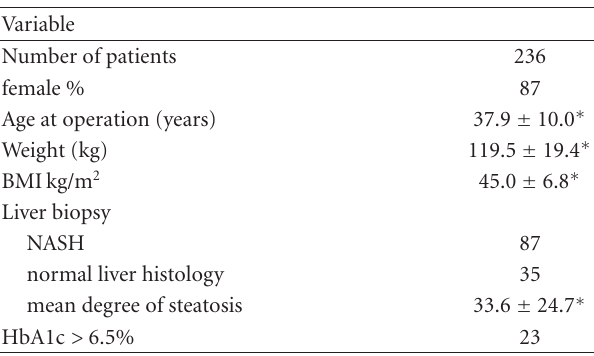
Table 1: Patient